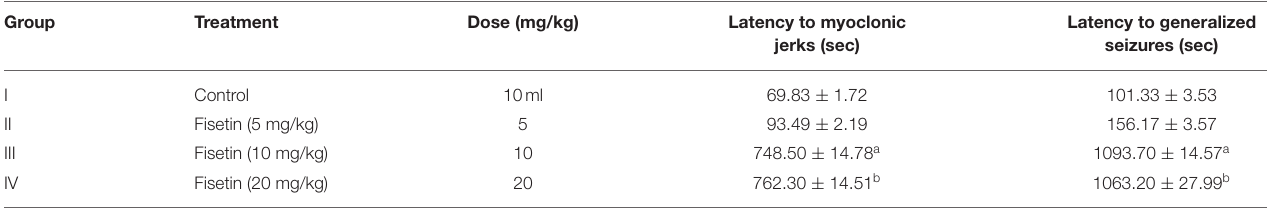
TABLE 2 | Effect of fisetin administration on PTZ-induced seizures in experimental mice. Group